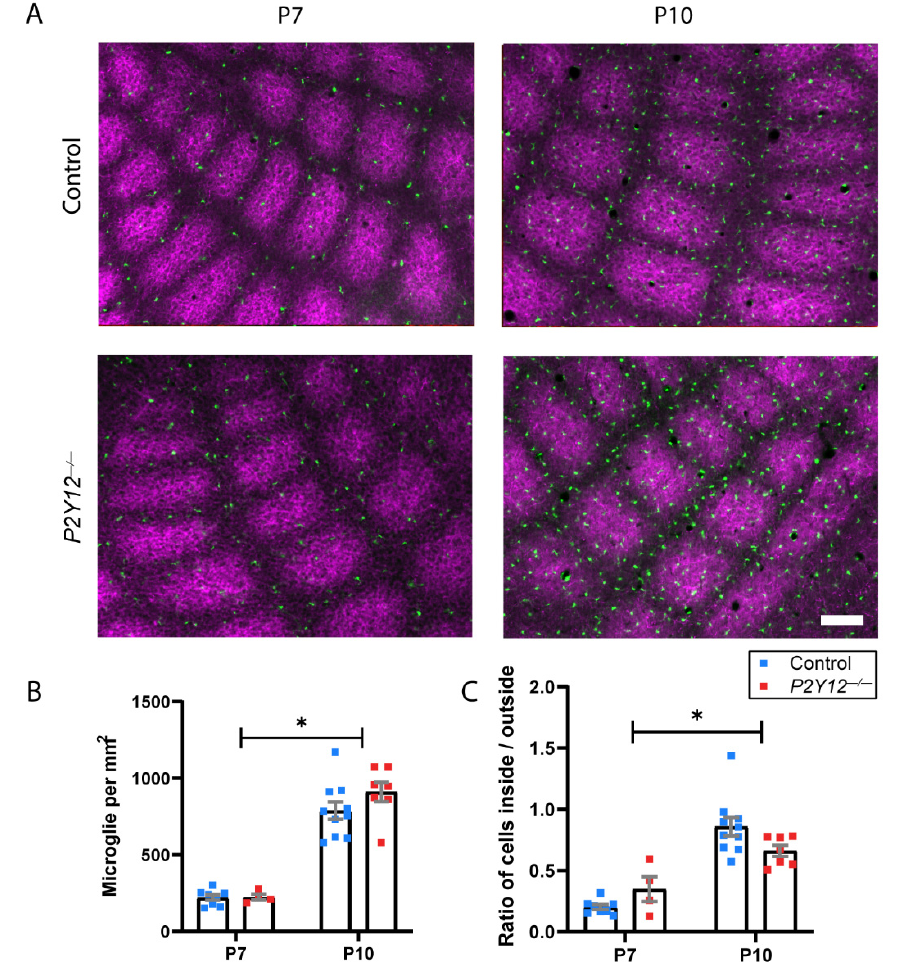
Figure 2. P2Y12 is not required for developmental microglial infiltration into thalamocortical axon (TCA) clusters in S1 barrel fields: ( A ) representative images of microglial (green) distribution inside 5-HTT-labeled TCA clusters (magenta) in tangential sections at P7 and P10 in Cx3cr1 G/+ and P2Y12 —/— / Cx3cr1 G/+ mice. Scale bar = 100 µm; ( B ) microglia density increases over time with no effect of genotype ( n = 4–10 per group); ( C ) the number of microglia inside TCA clusters increases over time with no effect of genotype. ( B ),( C ): two-way ANOVA, Sidak post hoc, * p < 0.0001; n = 4–10 per group; graphs show the mean +/ − SEM.